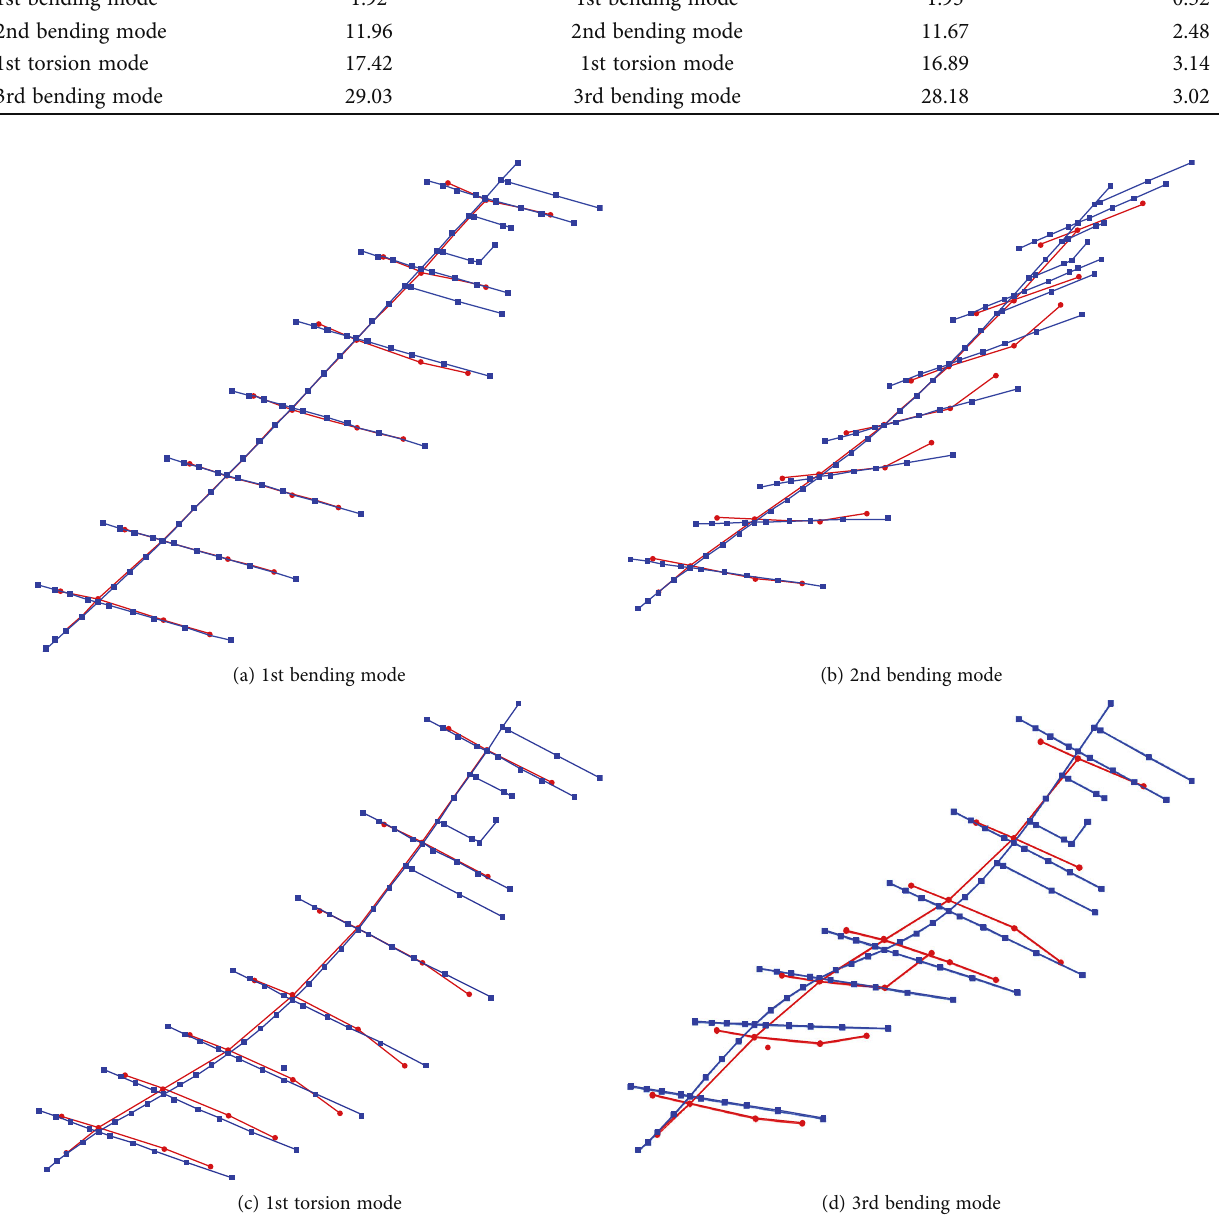
Figure 9: First four mode shapes of GVTs (blue dot: updated FE model; red dot: test